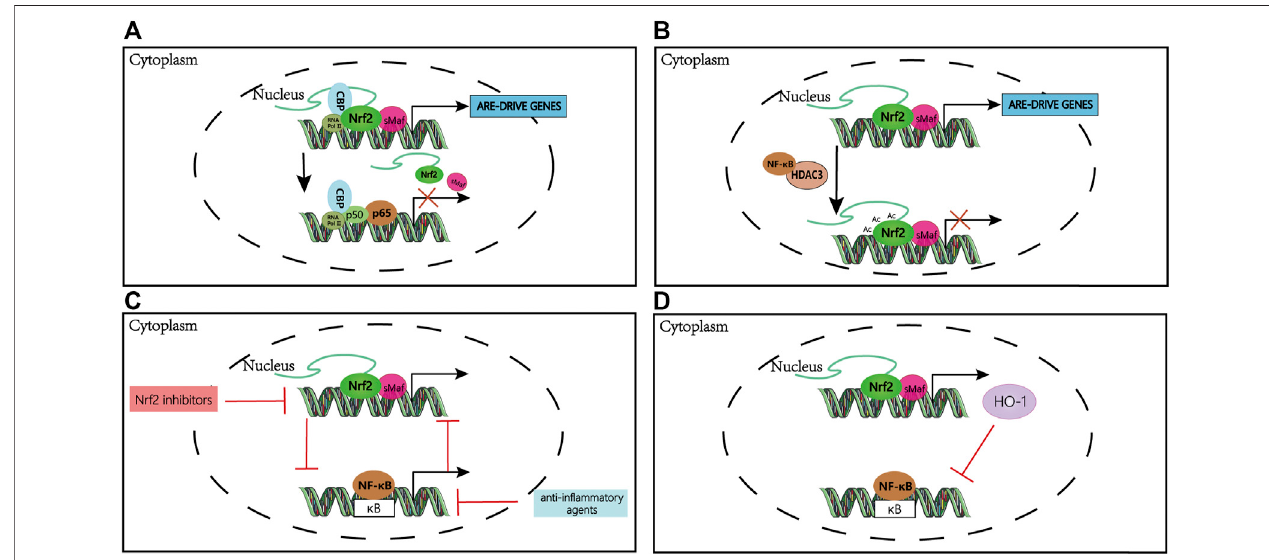
FIGURE 3 | The mechanism of crosstalk between Nrf2 and NF- κ B pathways. (A) Nrf2 and NF- κ B compete for CBP binding in the nucleus; binding of either transcription factor to CBP is dependent on the relative amount of translocated Nrf2 and NF- κ B. ( B) NF- κ B-recruited HDAC3 deacetylates Nrf2 inhibiting ARE- dependent gene expression. ( C) Nrf2is indirectly activated byanti-in fl ammatory compounds thatsuppressNF- κ B activity; likewise, NF- κ B is indirectly activated by Nrf2 inhibitors. ( D) HO-1, a downstream gene of Nrf2, can inhibit NF- κ B transcription. Abbreviations: CBP, CREB-binding proteins; HDACs, histone deacetylases; Ac, deacetylation; HO-1, heme oxygenase